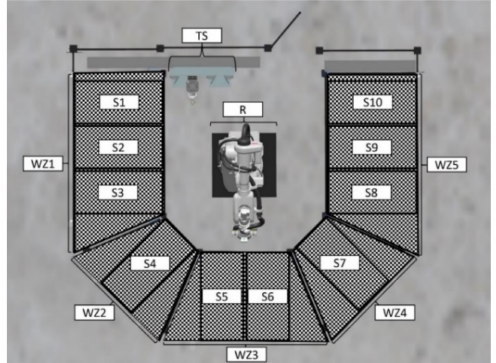
Figure 1. This figure shows a top view of the Plug and Produce, the tool stand (TS), the IRB 6700 (R) and its five work zones (WZ1-WZ5), where the work zones are marked with chequerboard. The figure also shows the ten slots (S1–S10) for mobile process modules. The figure is a snapshot from a simulation in